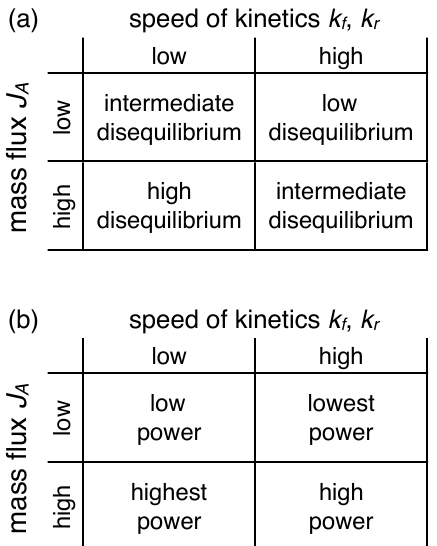
Fig. 2. Tables summarising some of the qualitative results illus- trated by our conceptual model. The labels J A , k f and k r refer to parameters of our model, discussed in the text. (a) The amount of disequilibrium in a flux-driven system (according to any measure that takes account of only the concentrations) depends upon both the magnitude of the fluxes and on the kinetic rates of the chemi- cal reactions that deplete them. The disequilibrium may generally be expected to be highest when the fluxes are fast and the kinetics slow, and at its lowest when the fluxes are slow and the kinetics fast. However, measures based on the concentrations alone cannot distinguish between the cases where the fluxes and the kinetics are both high from the cases where they are both low. This is impor- tant because the timescales of planetary processes vary over tens of orders of magnitude. (b) Similarly to disequilibrium, the power depends both on the fluxes and the kinetics, but the power is also proportional to the overall timescale, allowing it to distinguish the cases that disequilibrium alone